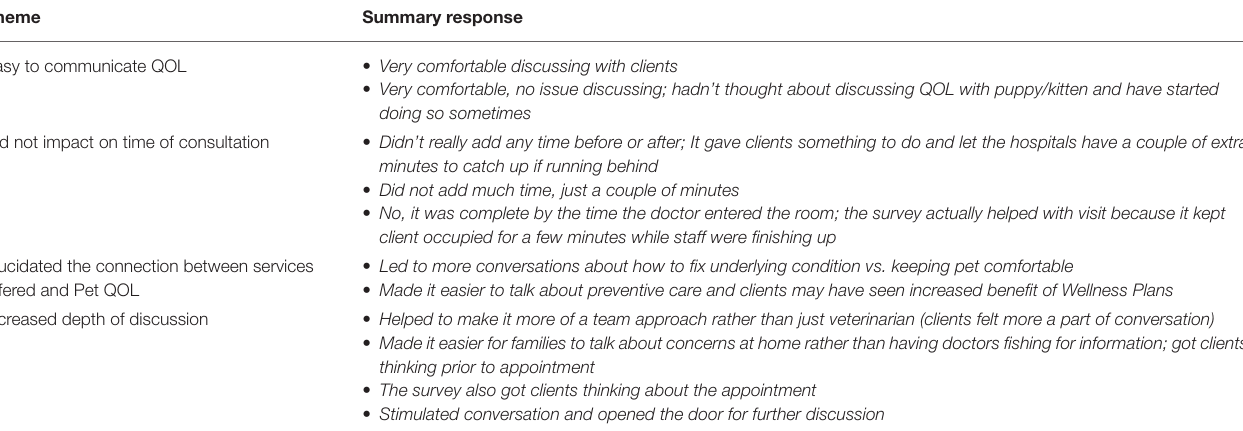
TABLE 5 | Summary of key themes from qualitative interviews with veterinary staff from participating